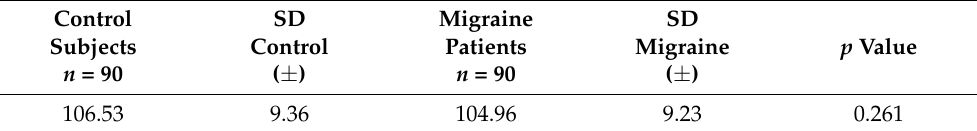
Table 4. Average peripapillary RNFL thickness ( µ m). Control